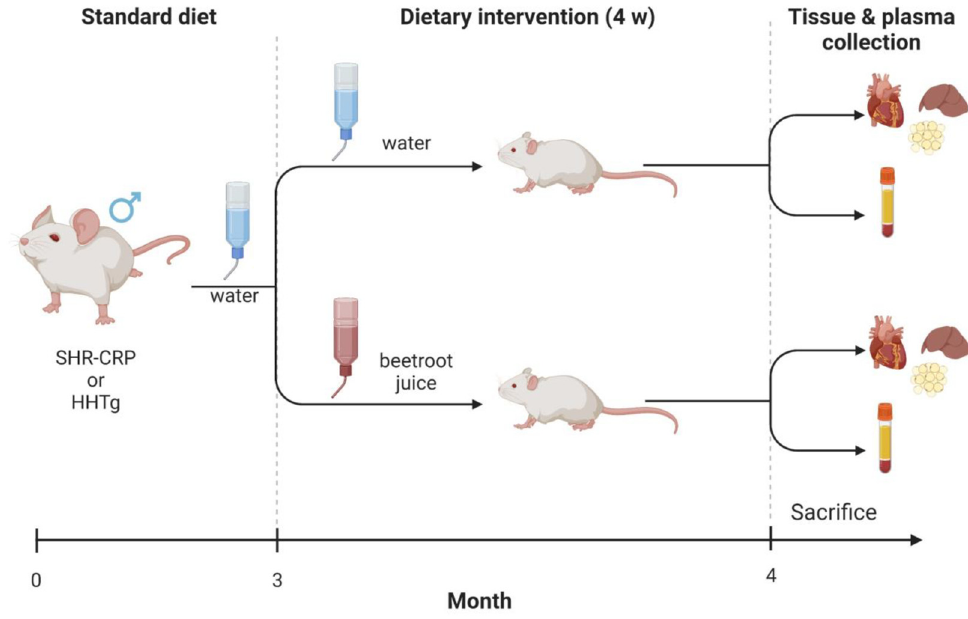
Figure 1. The protocol timeline. Male SHR-CRP and HHTg rats were fed standard laboratory chow and tap water ad libitum. At the age of 3 months, animals from each strain were divided into 2 groups: the experimental groups drank ad libitum beetroot juice for 4 weeks, while their respective controls drank tap water.